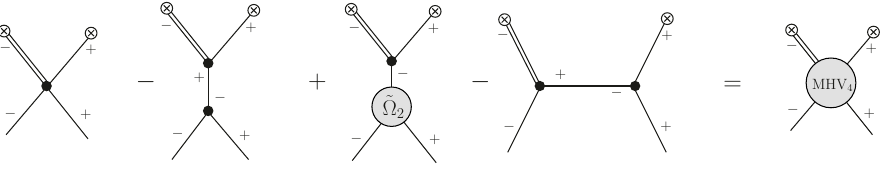
Figure 6 . Combination of un-traced diagrams, that leads to the MHV vertex under the logarithm term in the one-loop effective